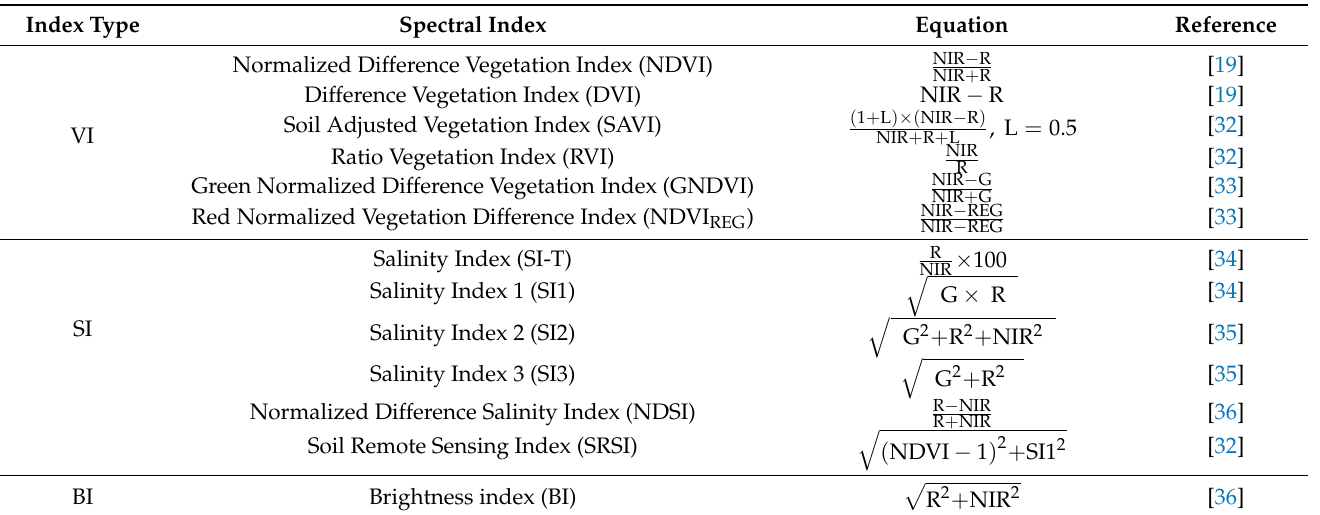
Table 2. Spectral indexes and equations. G represents the reflectance of the green band, R denotes the reflectance of the red band, REG is the reflectance of the red edge band, and NIR is the reflectance of the near-infrared